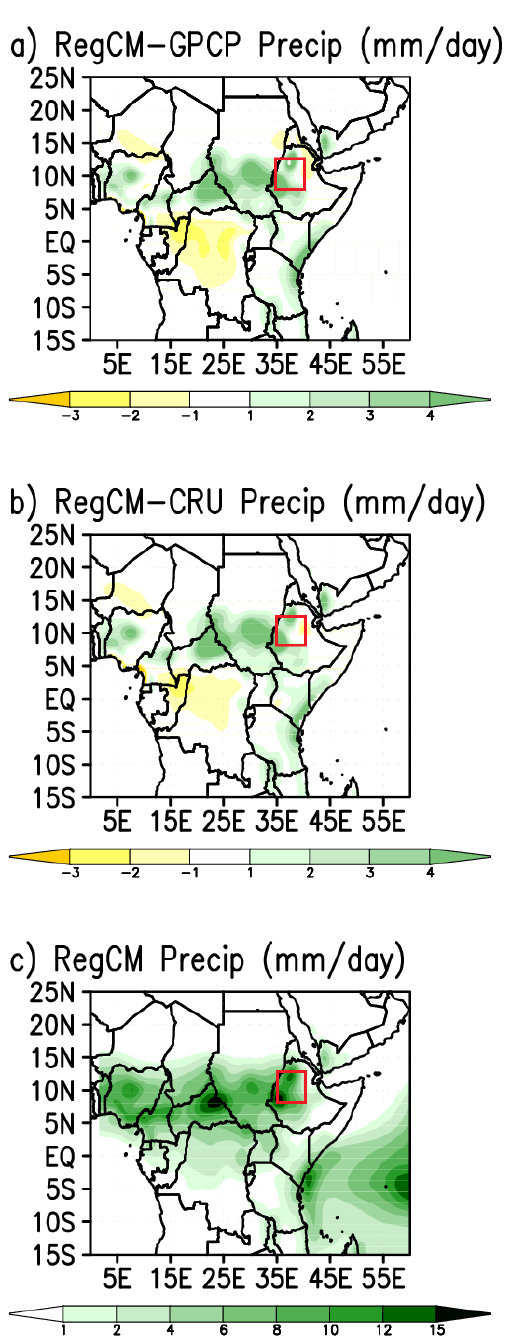
Figure 2. Averaged precipitation (in mm day − 1 ) for JJAS 1982– 2009: (a) Reg-TB minus CRU, (b) Reg-TB minus GPCP, and (c) RegCM. Model data are ensemble averages.